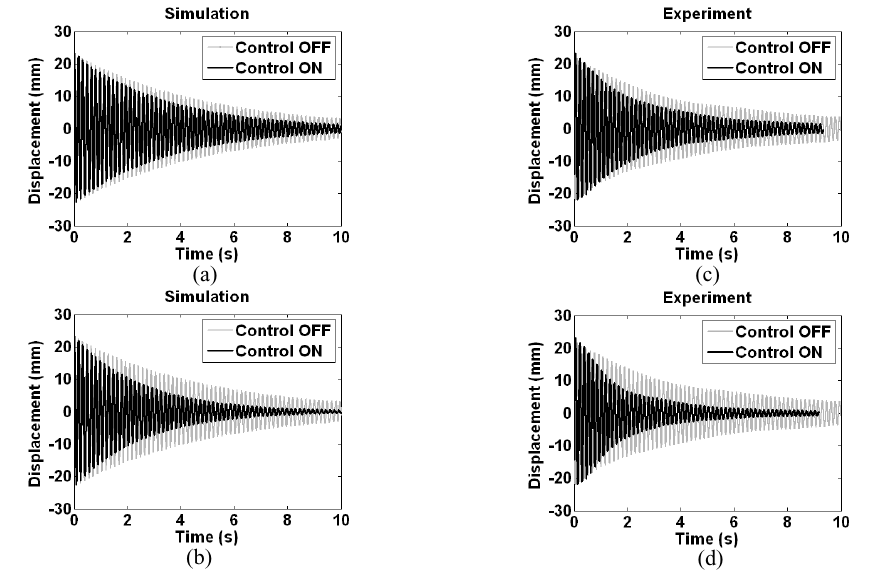
Fig. 8. Case 1 vibration responses for strain feedback control, simulation for (a) K p = 5 and (b) K p = 9, experiment for (c) K p = 5 and (d) K p = 9.